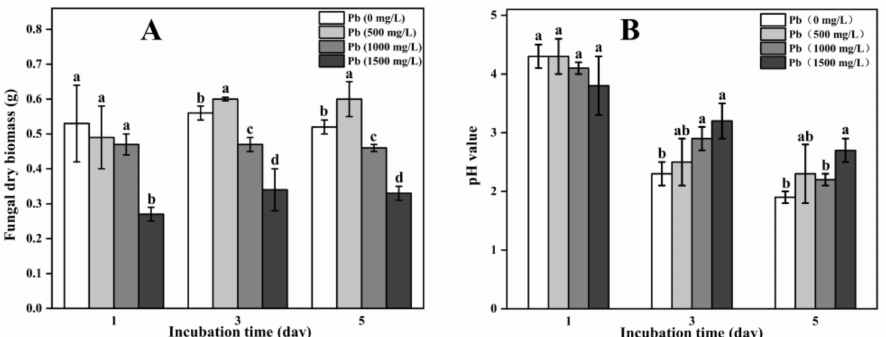
Figure 1. Fungal dry biomass ( A ) and pH value ( B ) in different Pb concentrations during the incubation time (1, 3, and 5 days). The error bars represent the standard deviations of three replicates for each treatment. The different lower-case letters indicate a significant difference between the treatments ( p <